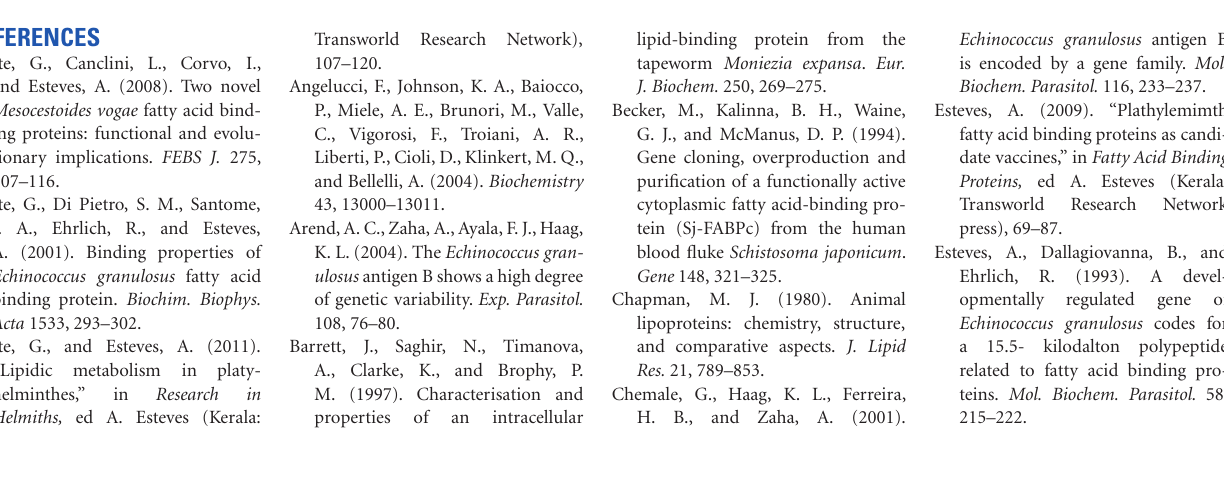
FIGURE 2 | In toto confocal immunomicroscopy of Mesocestoides vogae larvae. MvFABPswerevisualizedwithanantibodyagainstrEgFABP1 that recognizes both MvFABPs (A) . Nuclei stained with TO-PRO-3 family members suggests that their functions are not